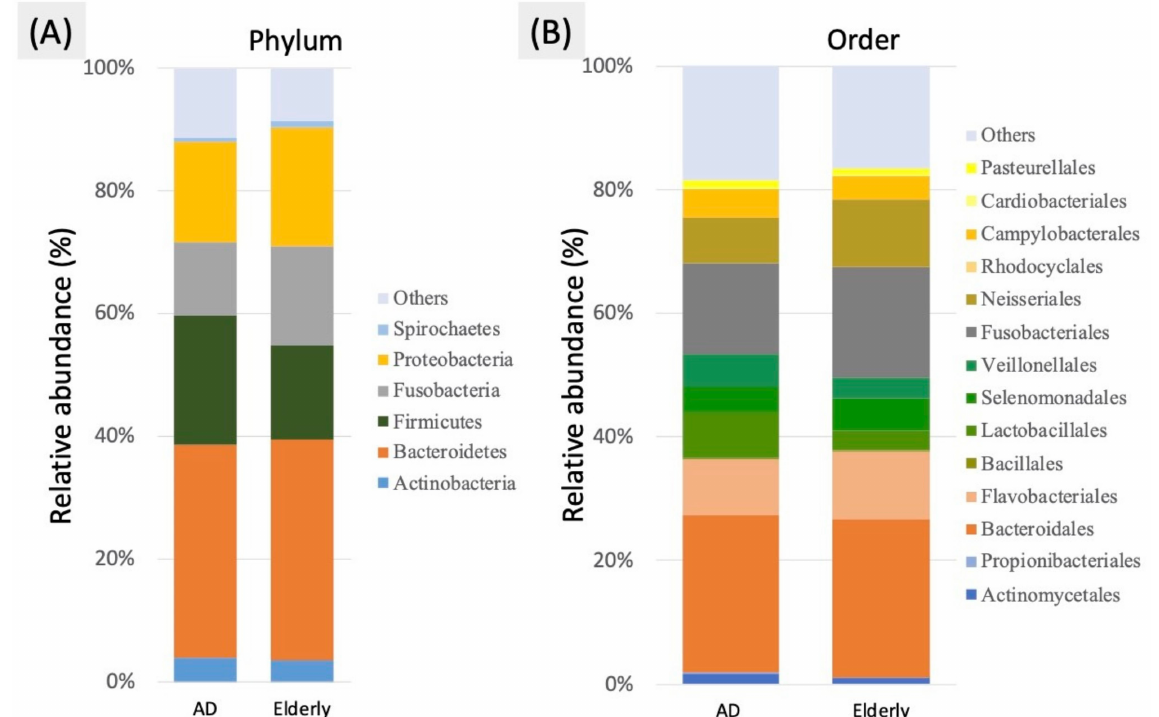
Figure 2. Average bacterial profile of OTUs of oral dental plaque in oral microbiota from the AD and control groups shown by the ( A ) phylum level bar plot ( B ) order level bar